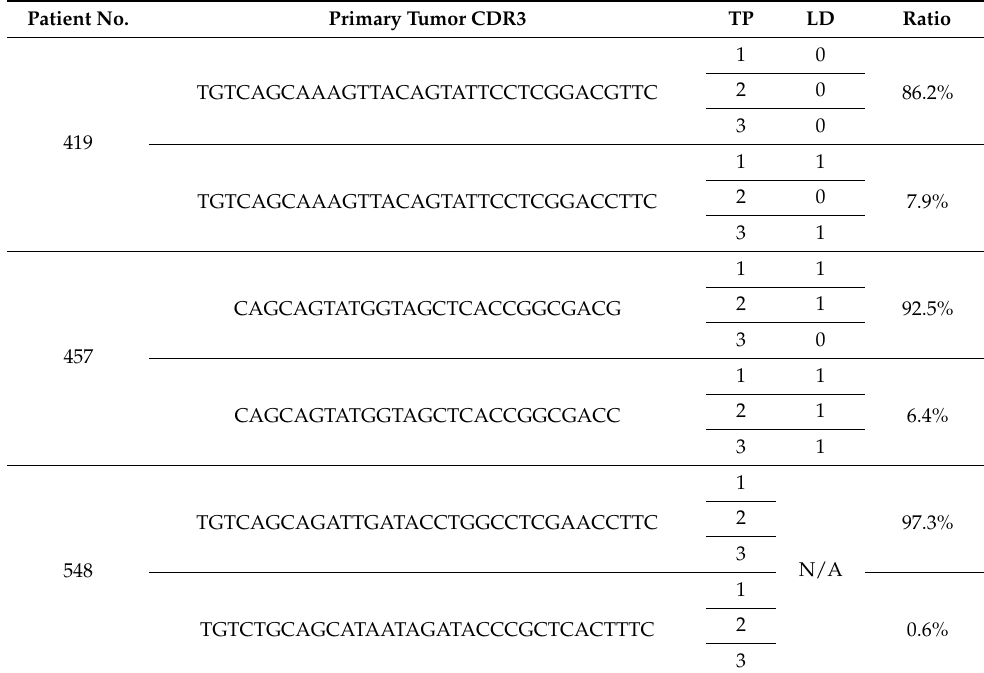
Table 2. Primary tumor B cell receptor CDR3 sequences of κ light chain. Patient No. Primary Tumor CDR3 TP LD